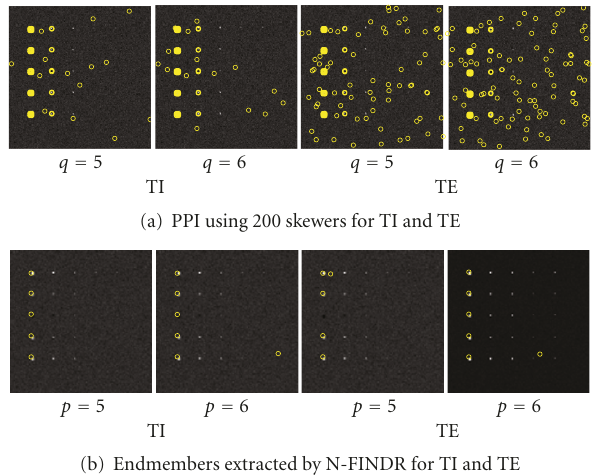
Figure 6: Endmember extraction results by PPI and N-FINDR for TI and